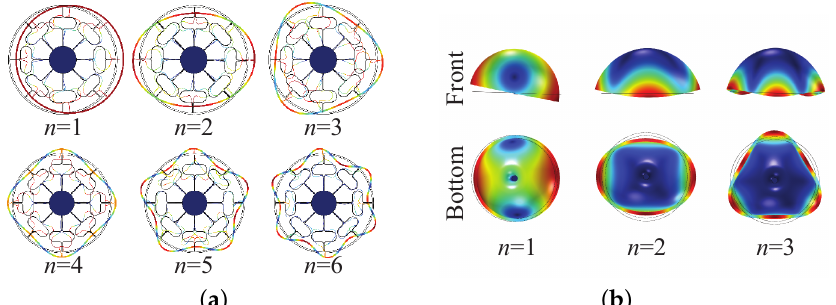
Figure 2. Flexural modes of the resonators: ( a ) First six in-plane flexural modes of an MRR. ( b ) First three flexural modes of an